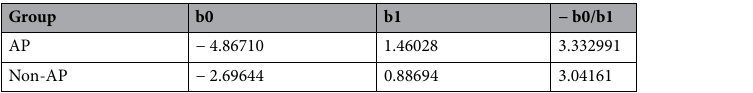
Table 1. Estimates of regression coefficients (b0, b1) and the derived mean categorical boundary (− b0/b1) for each group (AP and non-AP).